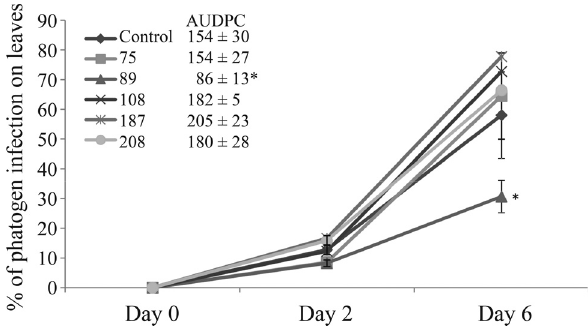
Figure5 -Percentageofpathogeninfection(average (cid:3) SE)andareaunder the disease progress curve (AUDPC) in the leaves of apple tree seedlings inoculated with bacterial isolates (75, 89, 108, 187 and 208) plus C. gloeosporioides conidia. * = significant difference compared to